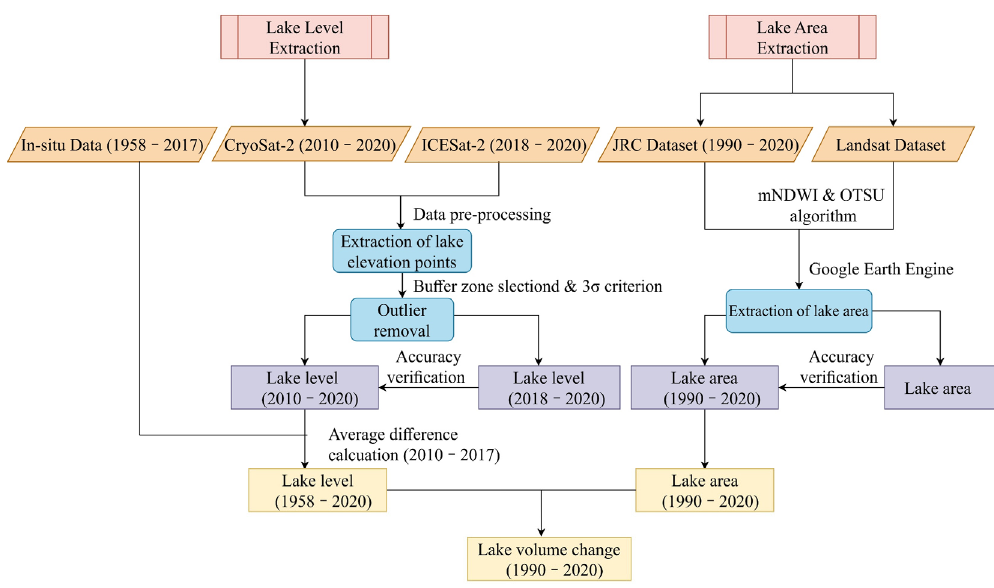
Figure 3. Flowchart of synthesizing multi-source data in this study.